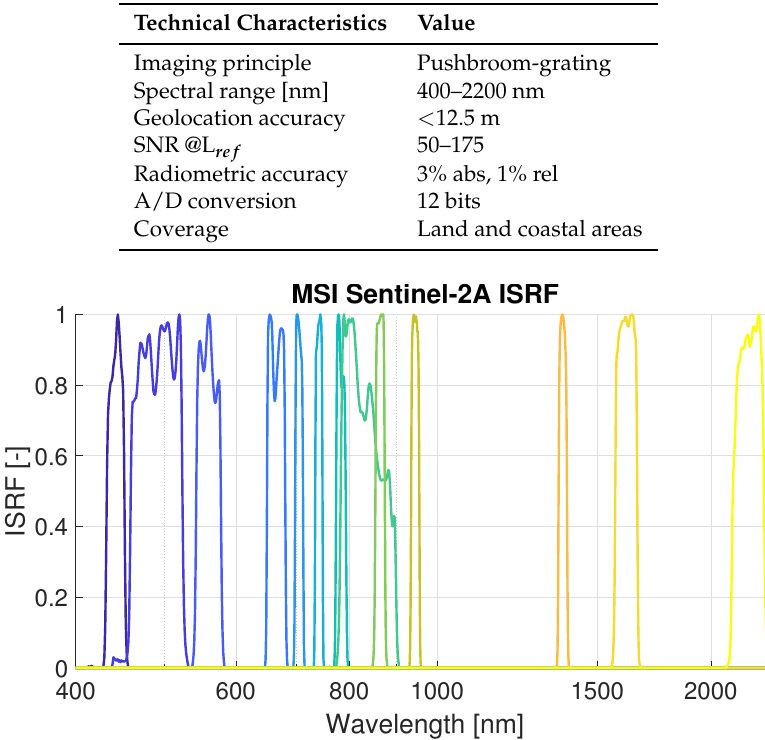
Figure 1. MSI-S2A spectral response function for the 13 spectral bands used by the Ground Segment from 15 January 2018